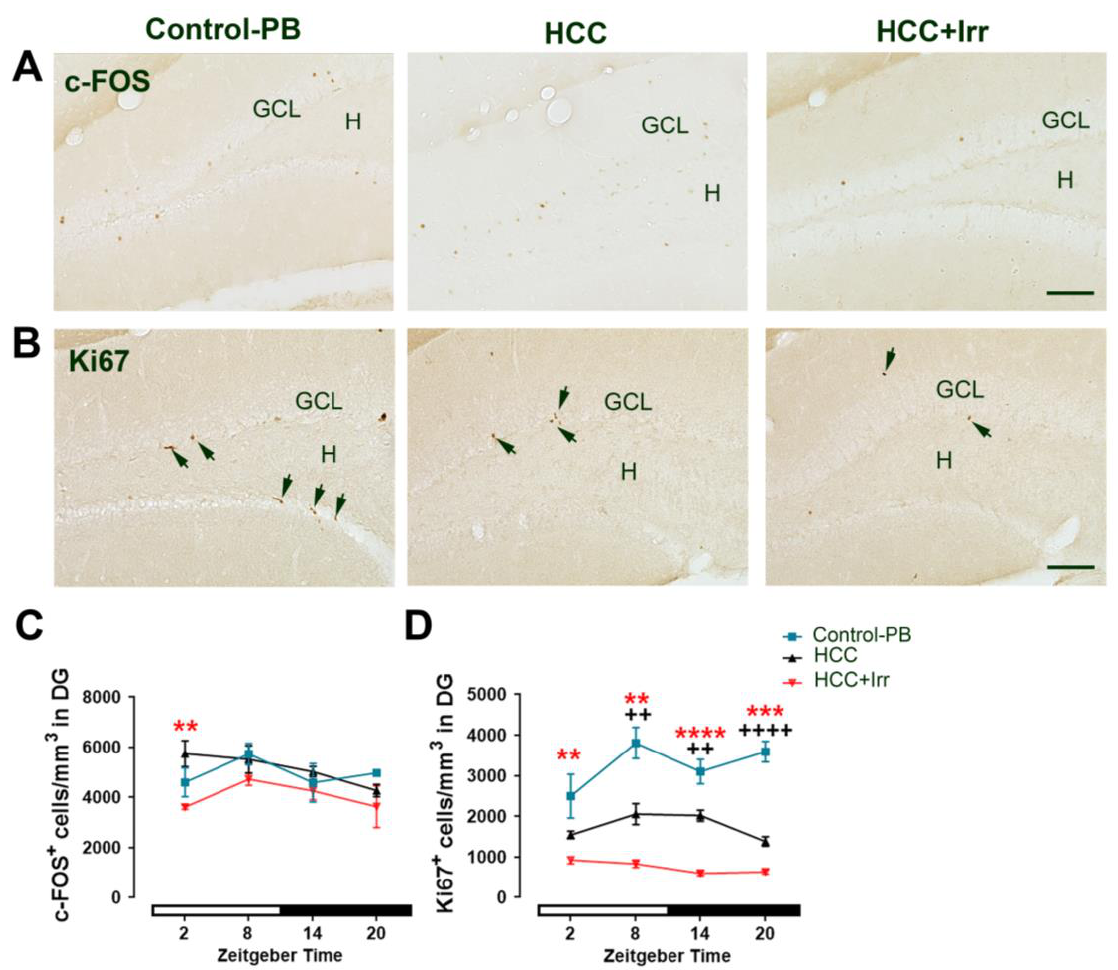
Figure 3. Effect of HCC and radiotherapy on neuronal activity and adult neurogenesis in the mouse hippocampus. ( A ) Representative photomicrographs of mouse hippocampal sections showing c- FOS+ neurons at ZT02 in control-PB, HCC-bearing mice and irradiated mice. ( B ) Representative photomicrographs of mouse hippocampal sections showing Ki67+ proliferating cells (black arrows) at ZT08 in control-PB, HCC-bearing mice and irradiated mice. ( C ) Quantification of cell density of c-FOS+ neurons/mm 2 in dentate gyrus (DG). ( D ) Quantification of cell density of Ki67+ proliferating cells/mm 2 in subgranular zone of the DG. Black crosses indicate differences between HCC mice and control-PB. Red asterisks indicate differences between HCC and HCC+Irr. **, ++: p < 0.01, *** p < 0.001, ****, ++++: p < 0.0001. White and black bars indicate the day/rest phase and night/activity phase, respectively. n = 12 mice per group, 3 mice at each time point, 2 sides per animal. GCL: granule cell layer, H: hilus. Scale bar = 100 µ m. Control-PB: control mice given phenobarbital (PB) in drinking water. HCC: HCC-bearing mice. HCC+Irr: HCC-bearing irradiated mice. Granular cell layer (GCL). Hilus